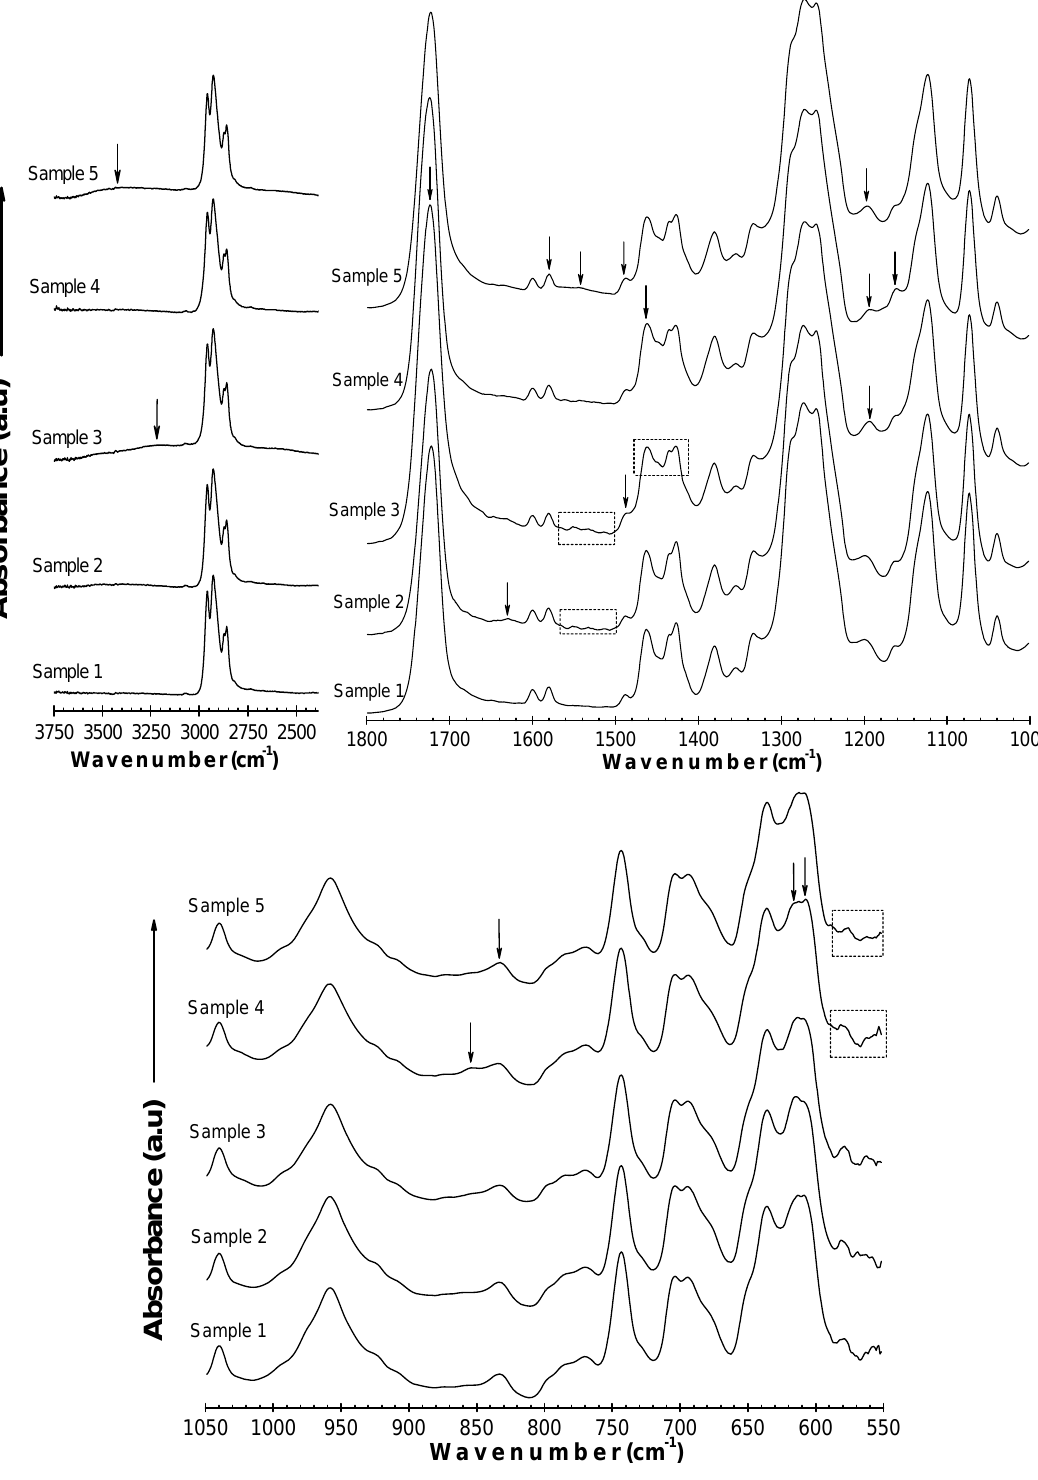
Figure 3. ATR-FTIR spectra of Samples 1–5 split over three wavenumber